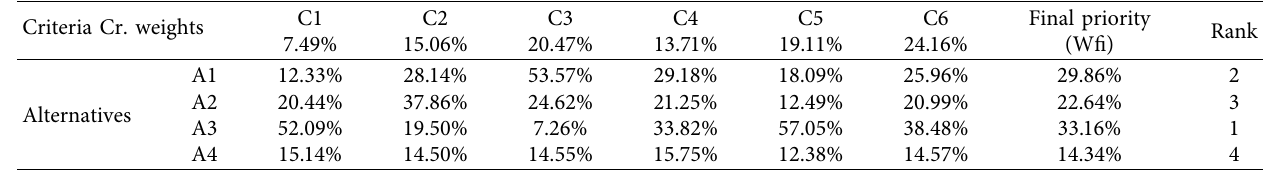
Table 7: Proposed alternatives along with criteria, fnal priority, and their ranks. Criteria Cr.